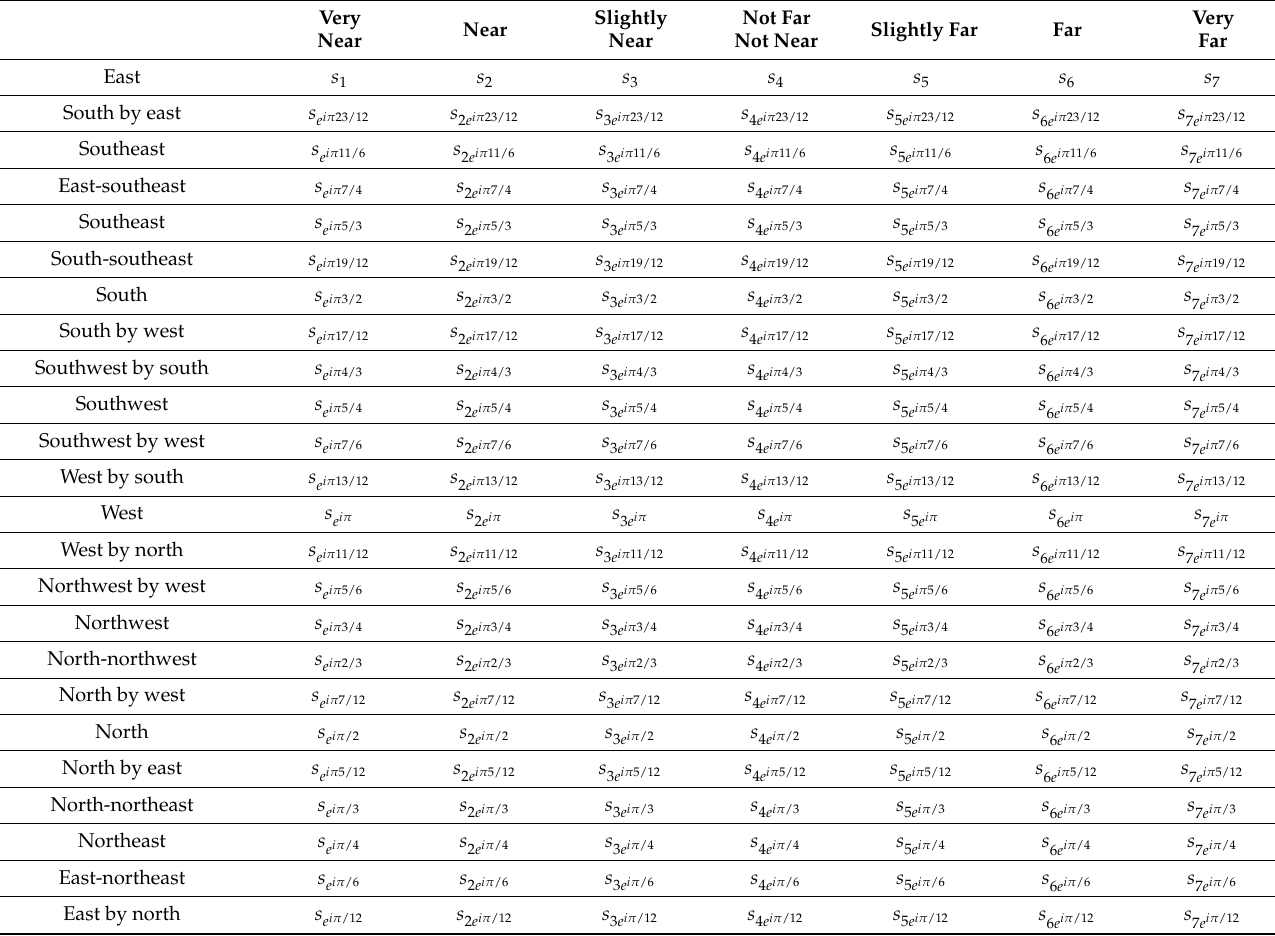
Table 1. Representation of spatial